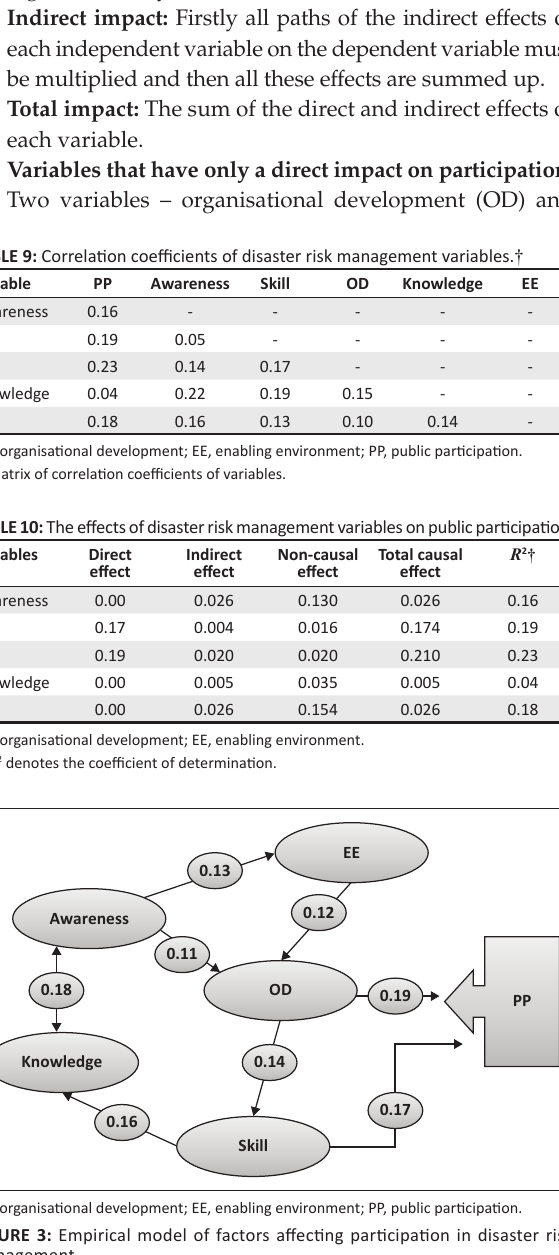
FIGURE 3: Empirical model of factors affecting participation in disaster risk management.